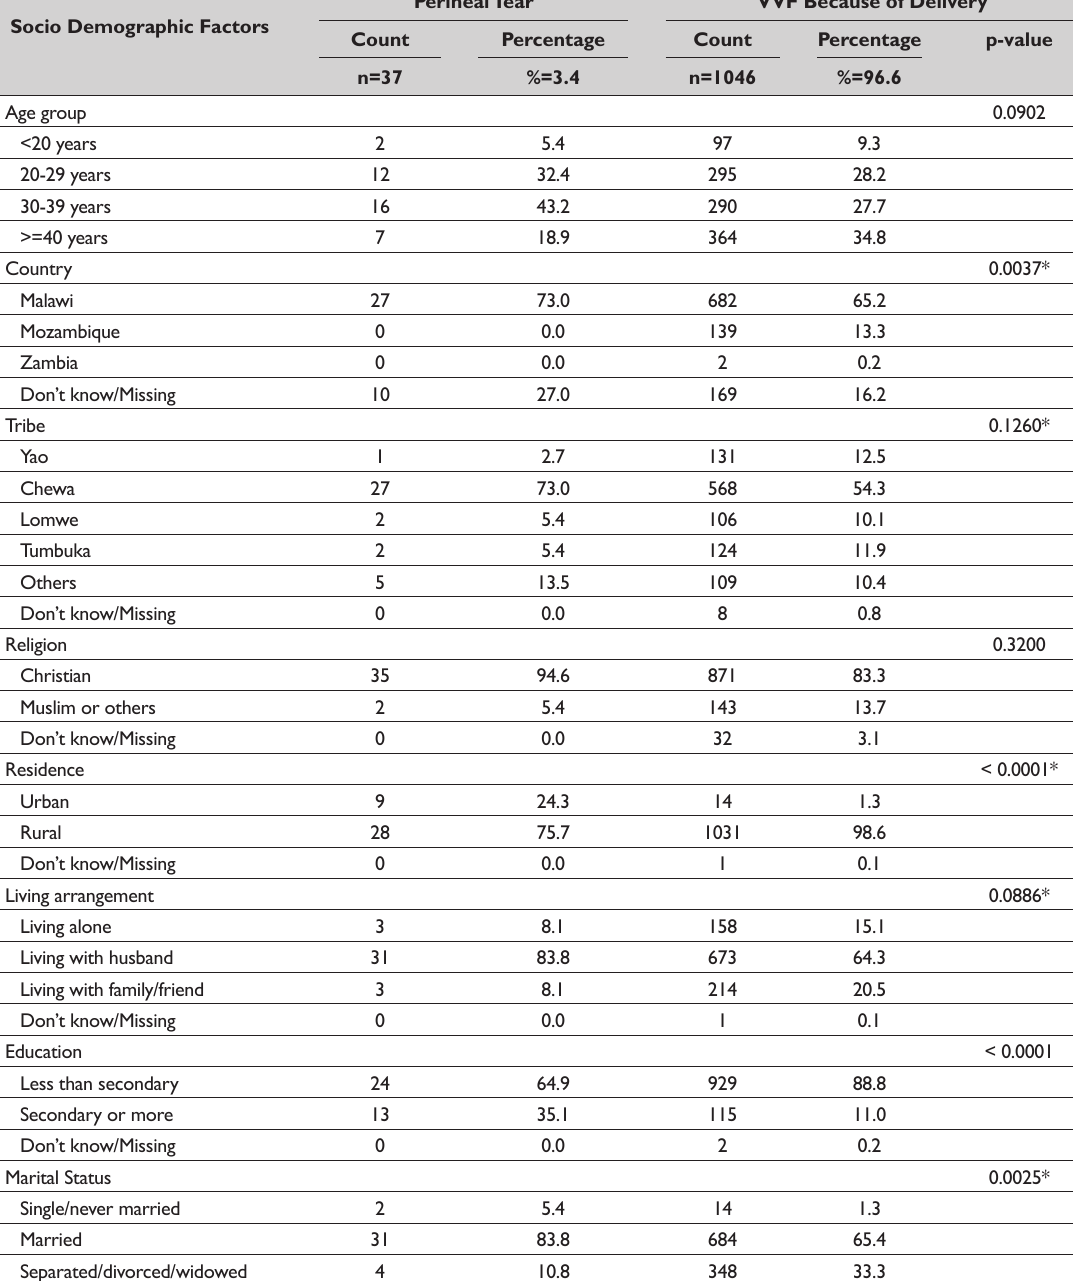
Table 1: Comparison of selected socio-demographic characteristics of women hospitalized for VVF (vesicovaginal fistula) versus those with perineal